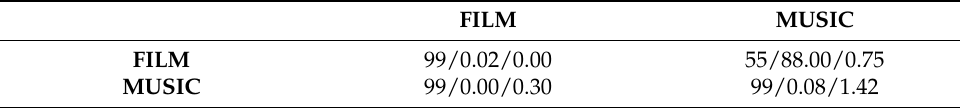
Table 5. ACC, FAR and FRR for the 1st SVM classifier (%).